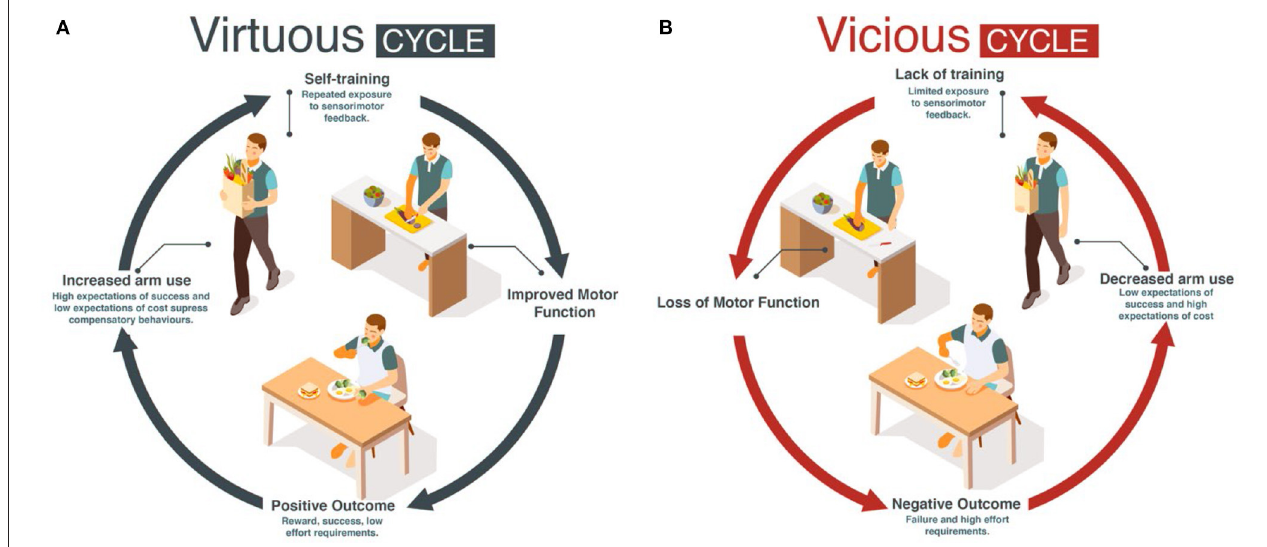
FIGURE 1 | Conceptual model: the virtuous (A) and vicious (B) recovery